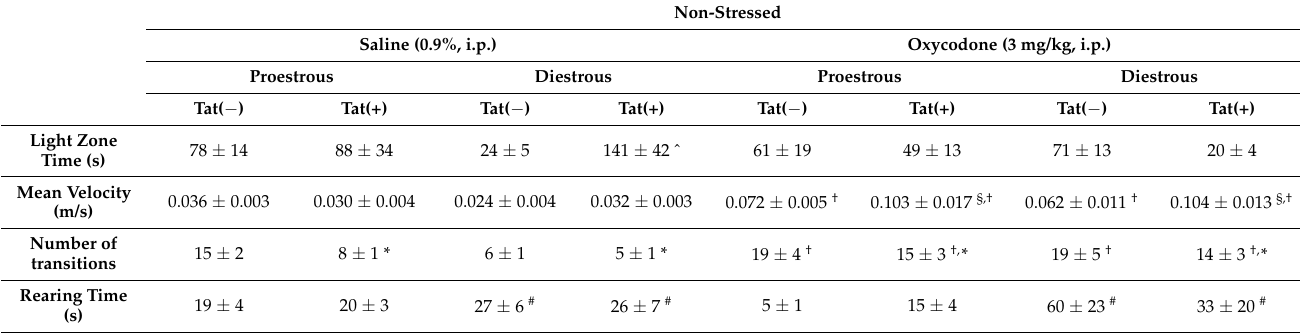
Table 1. Motor and anxiety-like measures for Tat( − ) and Tat(+) female mice assessed in open field and light-dark transition tests. Proestrus or diestrous mice were administered saline or oxycodone prior to behavioral assessment. * indicates a main effect of genotype wherein Tat(+) mice differ from Tat( − ) controls. † indicates a main effect of drug condition wherein oxycodone-administered mice differs from saline-administered controls. # indicates a main effect of estrous cycle wherein diestrous mice differ from proestrous mice. § indicates an interaction wherein oxycodone-administered Tat(+) mice differ from Tat( − ) controls and saline-administered controls. ˆ indicates an interaction wherein saline-administered, diestrous Tat(+) mice differ from all other groups except for their respective proestrous counterparts, p < 0.05. Non-Stressed Saline (0.9%, i.p.)